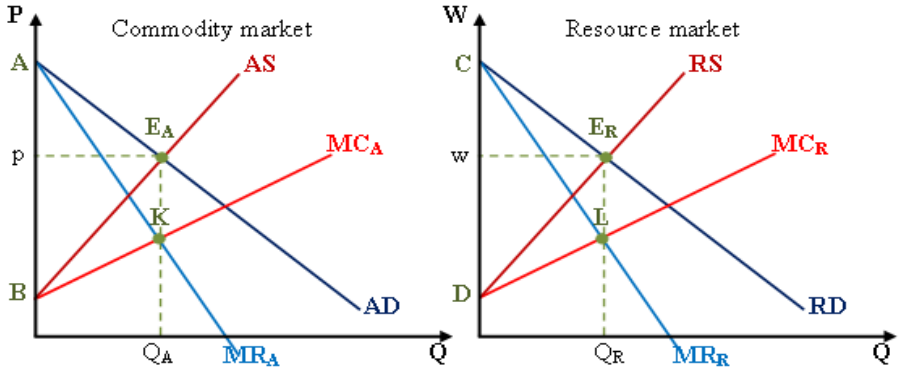
Figure 2. The equilibriums of AD-AS and RD-RS.